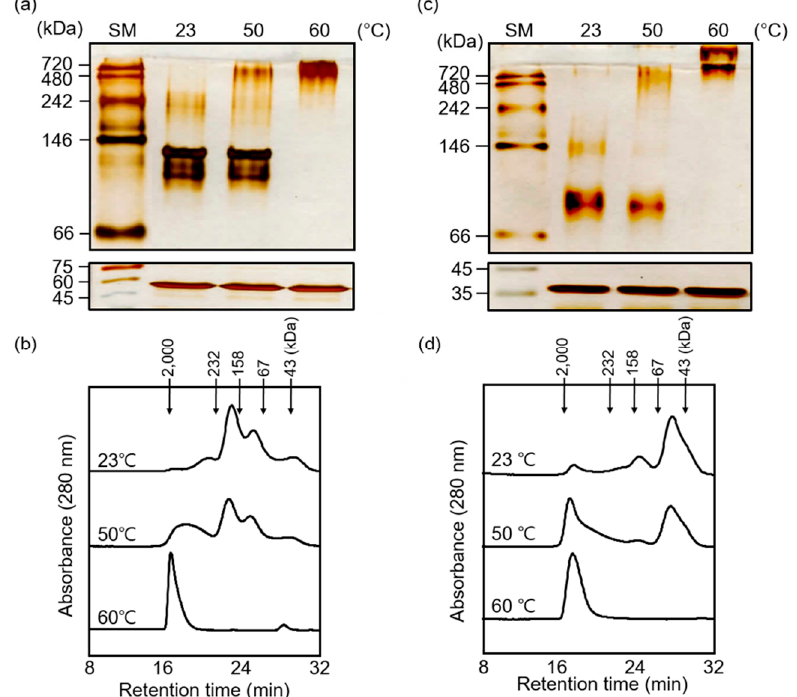
Figure 9. Heat shock-dependent structural changes in AtTPR10, ANK-D, and TPR-D. ( a )–( d ) Analysis of heat shock-dependent structural changes by 10% native gel electrophoresis ( a ) and ( c ) and SEC using HPLC ( b ) and ( d ) upon incubation at different temperatures (23 °C, 50 °C, and 60 °C) for 30 min. SM represents the size marker ( a ) and ( c ).